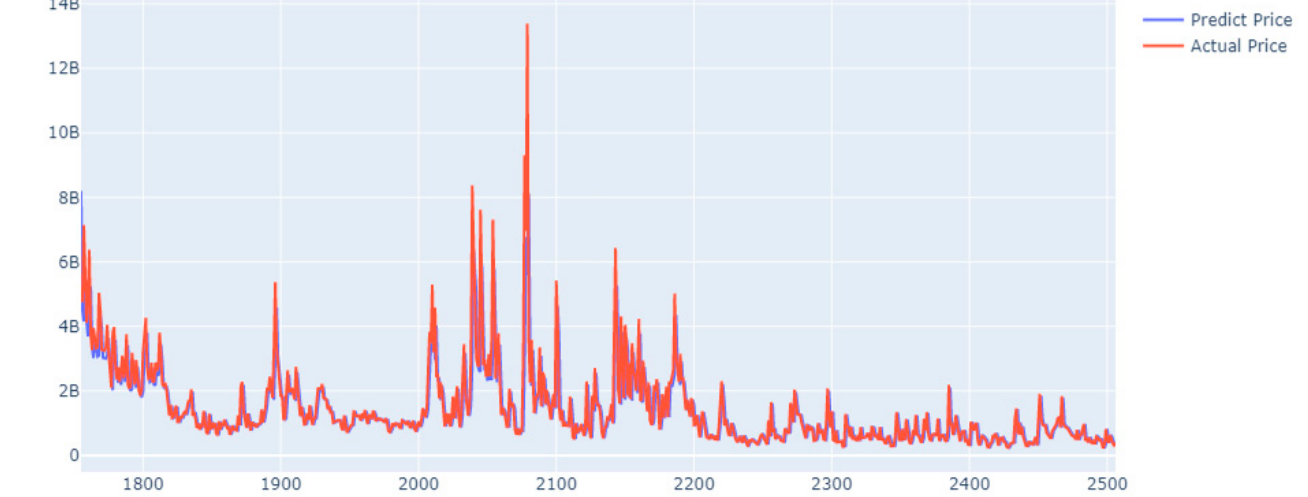
Figure 5. Time series plot of the LSTM model for predicting the price of the AMP cryptocurrency.